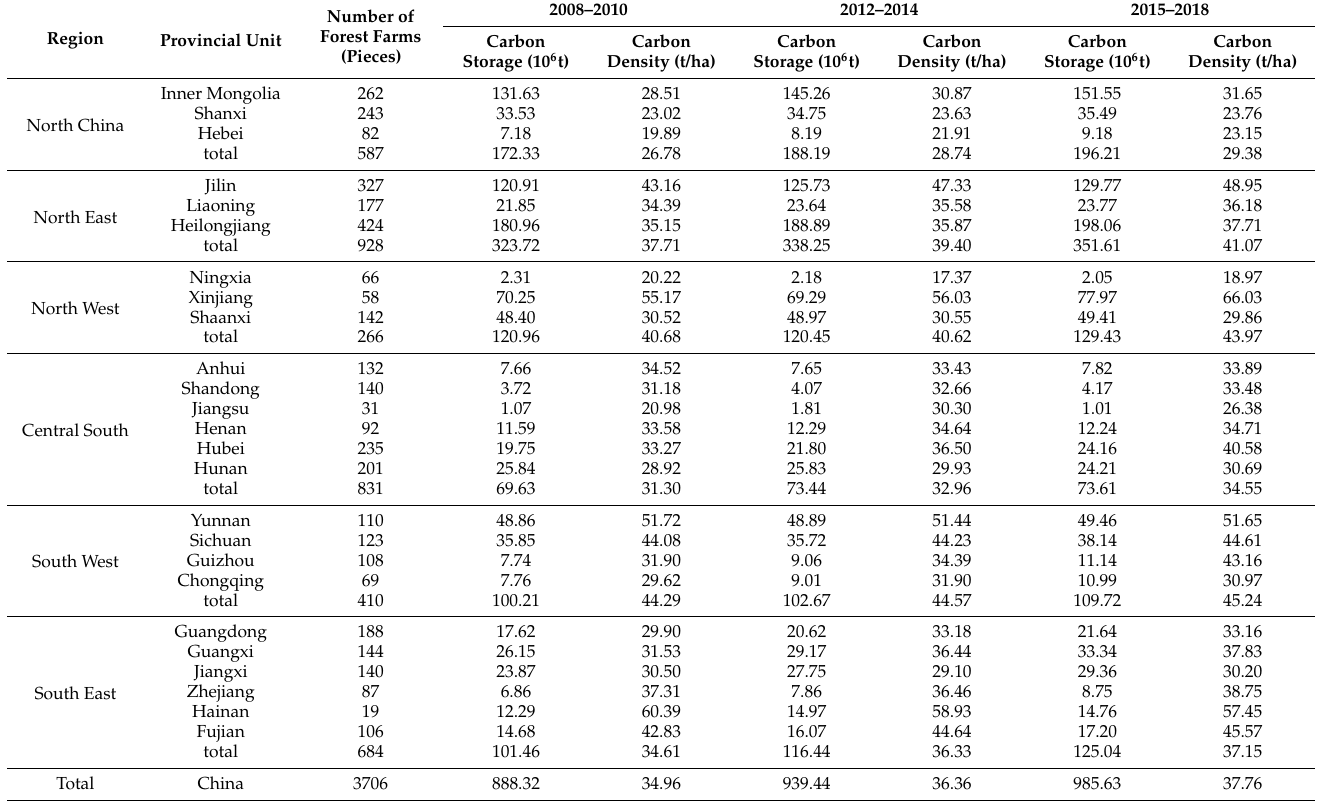
Table 2. Carbon storage and carbon density of state-owned forest farms in China’s provinces in three periods